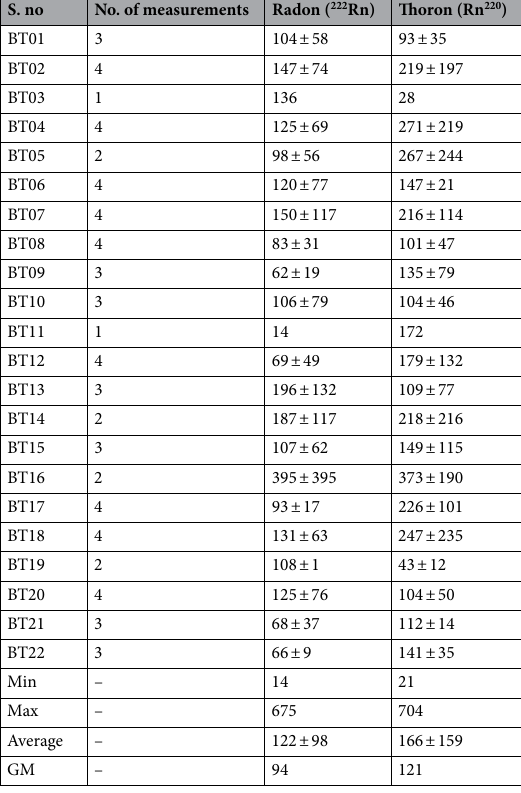
Table 1. The average concentration of radon and thoron (Bq m −3